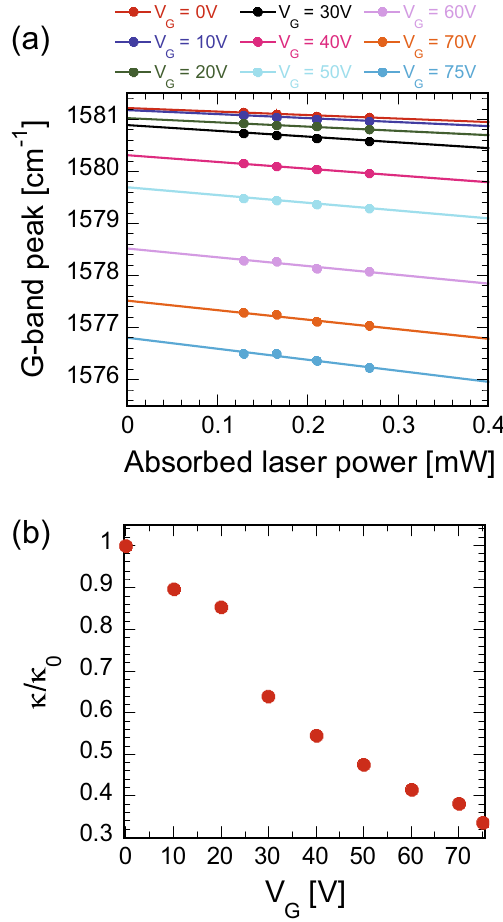
Figure 6. ( a ) Raman G band peak positions of the suspended graphene drum for DEVICE 2 obtained with four different laser powers at various voltages V G . ( b ) Change in the thermal conductivity with respect to the voltage. As V G increases, voltage dramatically decreases. Values are normalized by that at V G = 0